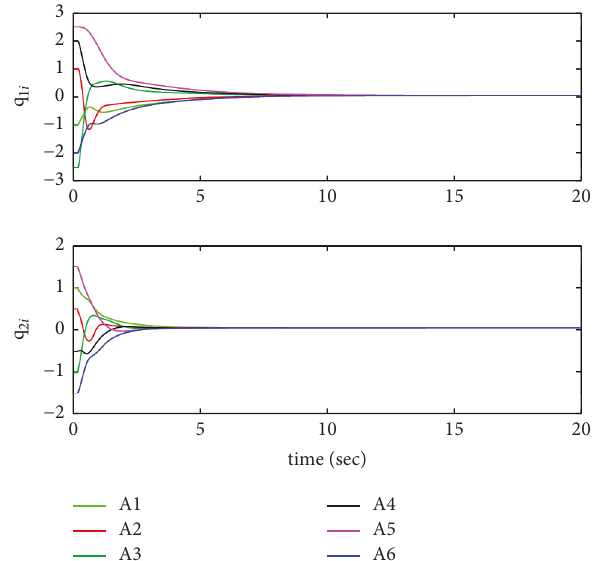
Figure 8: Simulation results of states q